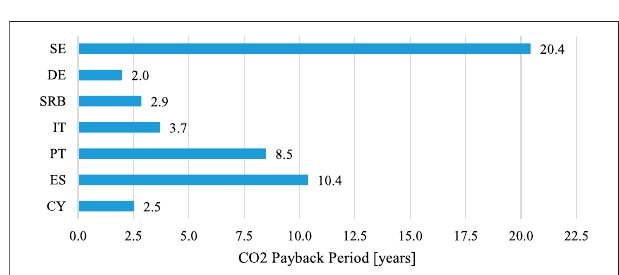
FIGURE 9 | CO 2 payback period per country for the double U-tube GSHP system (compared to ASHP), with baseline COPs as presented in Figure 1 , for the GWP impact per